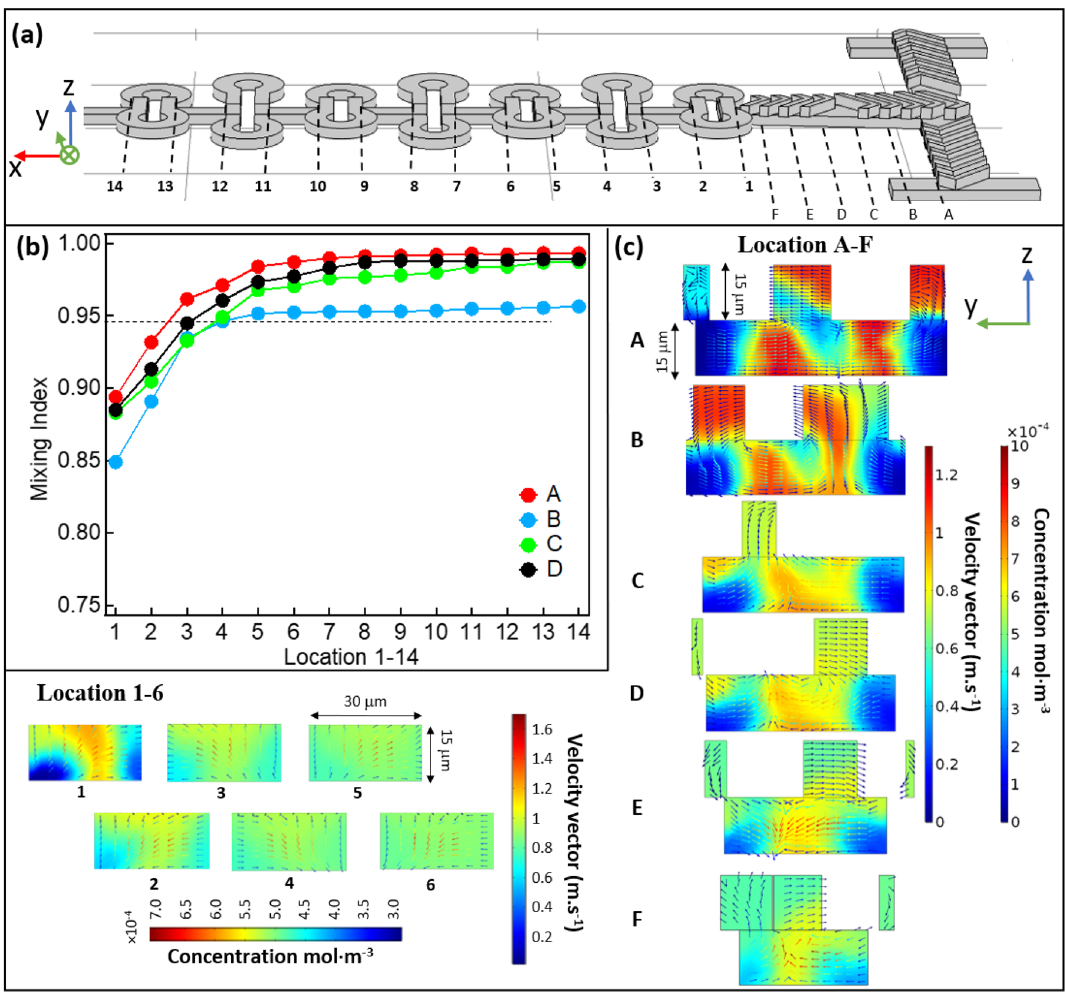
Figure 5. Represents the simulation results along the mixing channel of all the four designs at Q = 6 µL·min −1 , Re ~ 4.7 in pre-mixer and ~ 20 in ring-shaped units. (a) side view of the mixer pattern A with position marks in the main mixing channel and in the ring-shaped mixing zone. (b) Mixing index data obtained by simulation of the evaluated sample for all four cases in Fig. 4, same conditions were applied. The concentration data chosen here for the mixing indices calculation were extracted from the concentration profile projected onto the z–y plane at the locations labelled 1–6 on the mixing channel of panel (a) . (c) shows the slice concentration profile projected onto the z–y plane at the locations labelled A–F on the mixing channel of panel (a) , with the distributions of the velocity vectors overlayed on the same profile. The color bars for the concentration profile are presented besides, with the concentration ranging from 0 to 10 × 10 –4 mol·m −3 . The simulations were performed with the COMSOL Multiphysics software (https:// www. comsol.